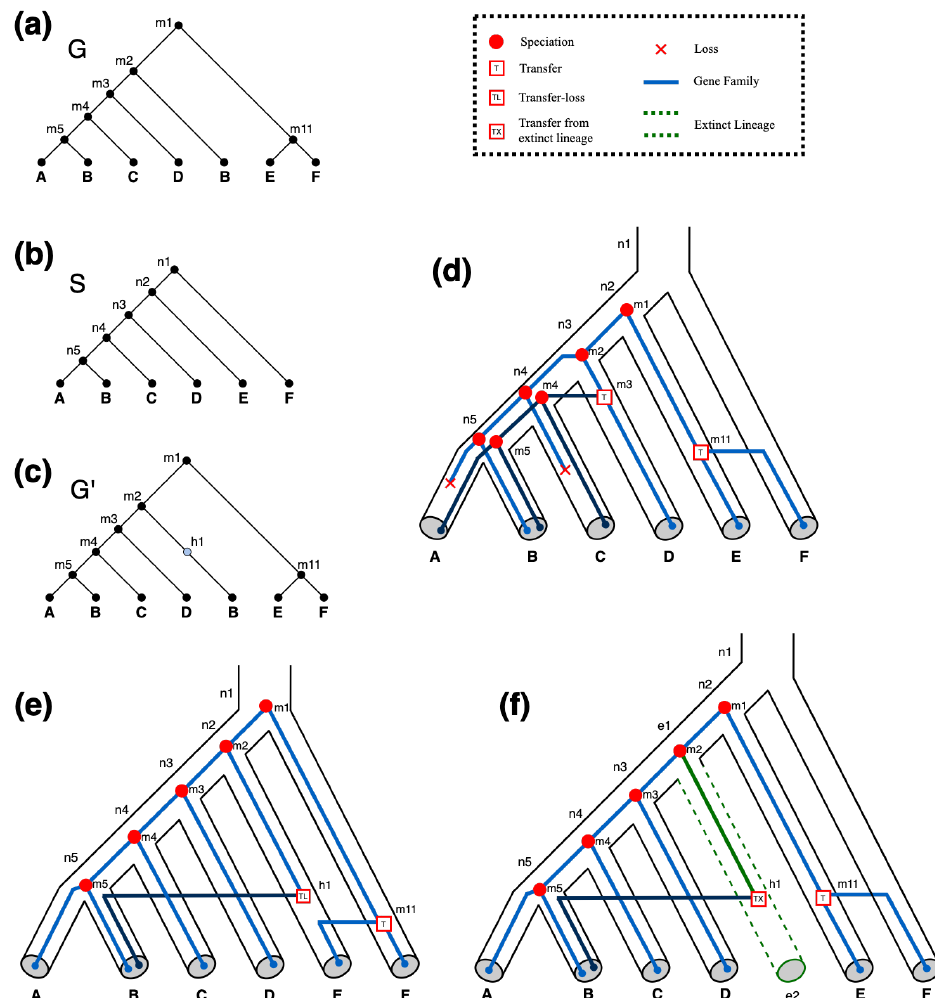
Figure 4. Impact of TL and TX events on optimal DTLx reconciliations. ( a ) and ( b ) are the input gene tree G and input species tree S , respectively. ( c ) An augmented version of G containing a single hidden node as required by the reconciliations shown in Parts ( e , f ). ( d ) An optimal DTL reconciliation of G and S illustrating how the gene tree (blue lines) may have evolved within the species tree (tubes) without the use of TL or TX events. This DTL reconciliation invokes two transfer events and two losses. All reconciliations shown in this figure use event costs of 1, 2, 3, 4, and 3 for losses, duplications, transfers, TL , and TX events, respectively. Thus, we get a total reconciliation cost of 8 for this optimal DTL reconciliation. ( e ) An optimal reconciliation of G and S that uses TL events but not TX events. This reconciliation utilizes the hidden node h1 in G (cid:48) to facilitate a TL event from species E to species B. It invokes one transfer event and one TL event, for a total reconciliation cost of 7. ( f ) An optimal DTLx reconciliation of G and S . This DTLx reconciliation utilizes the hidden node h1 in G (cid:48) to facilitate a TX event. It invokes one transfer event and one TX event, for a total reconciliation cost of 6. Accordingly, the reconciliation shown in ( f ) makes use of an extra leaf and extra node on S (cid:48) (dotted green